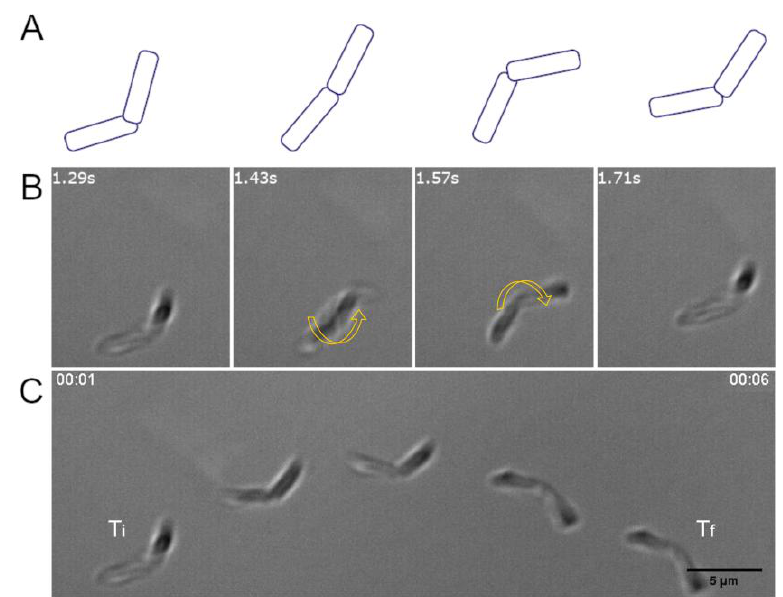
Figure 3. B. subtilis swimmer constituted by two chained cells swimming by bending up and down. ( A ), schematics and ( B ), corresponding microscopy images illustrating the up and down bending movement (indicated by the two yellow arrows) of two B. subtilis chained cells swimming. ( C ), time lapse microscopy images of the resulting swimming pattern. Ti, initial time; Tf, final time. The images in ( B ) correspond to the first frames of the time lapse presented in ( C ). Strain W168. Scale bar 5 µm for all images. White numbers indicate time in seconds.